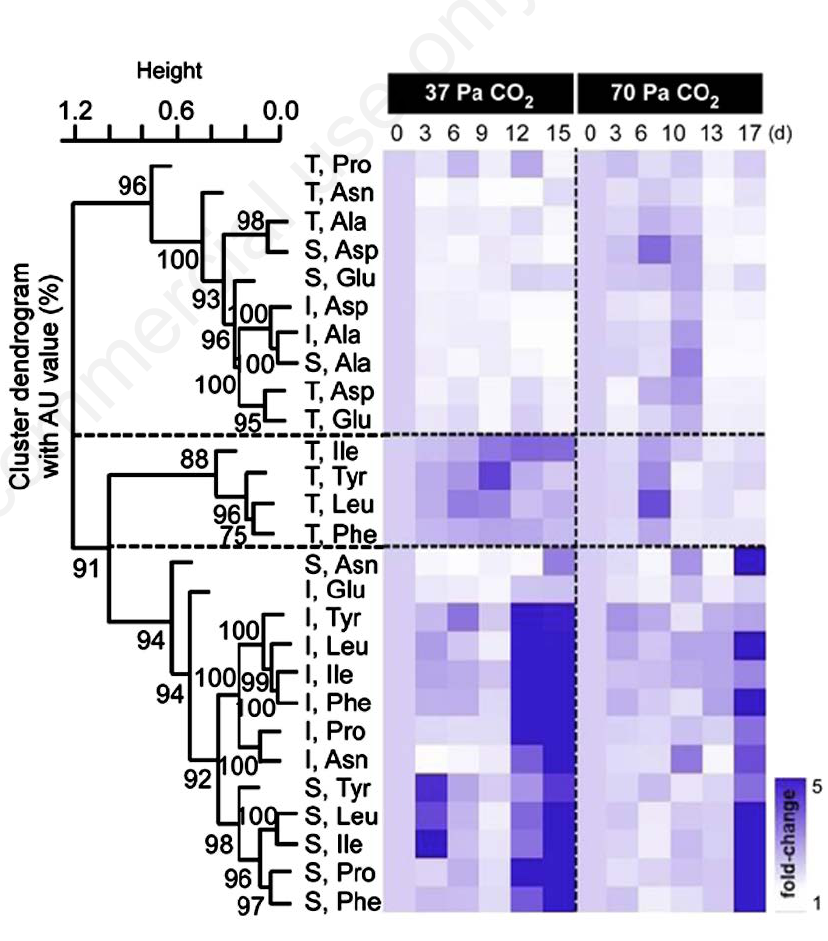
Figure 4. Hierarchical clustering analysis. Statistical relationships are shown for the com- bined effects of the duration of drought and CO enrichment on the 9 amino acids shown 2 in Figure 3. Harvest dates corresponding to the duration of drought in either the ambient or elevated CO treatments were on the horizontal axis. Metabolite clusters depicting the 2 relative differences between the water sufficient and insufficient samples are given on the vertical axis. Ratios that are 1:1 are shown in white and ratios greater than 1 are shown in gradations of blue. The abbreviations T, I and S refer to the tolerant, intermediate and sensitive maize hybrid lines,